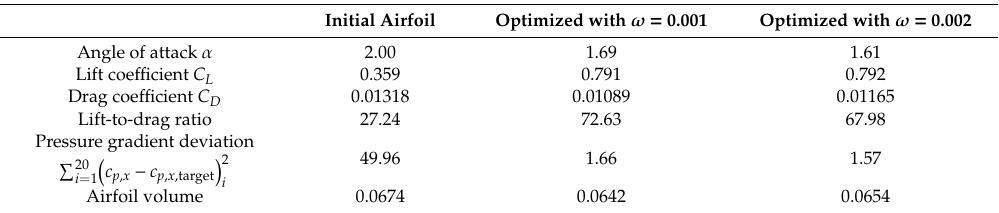
Table 2. Aerodynamic coefficients of the airfoils ( Ma = 0.73, Re = 6.5 × 10 6 ).